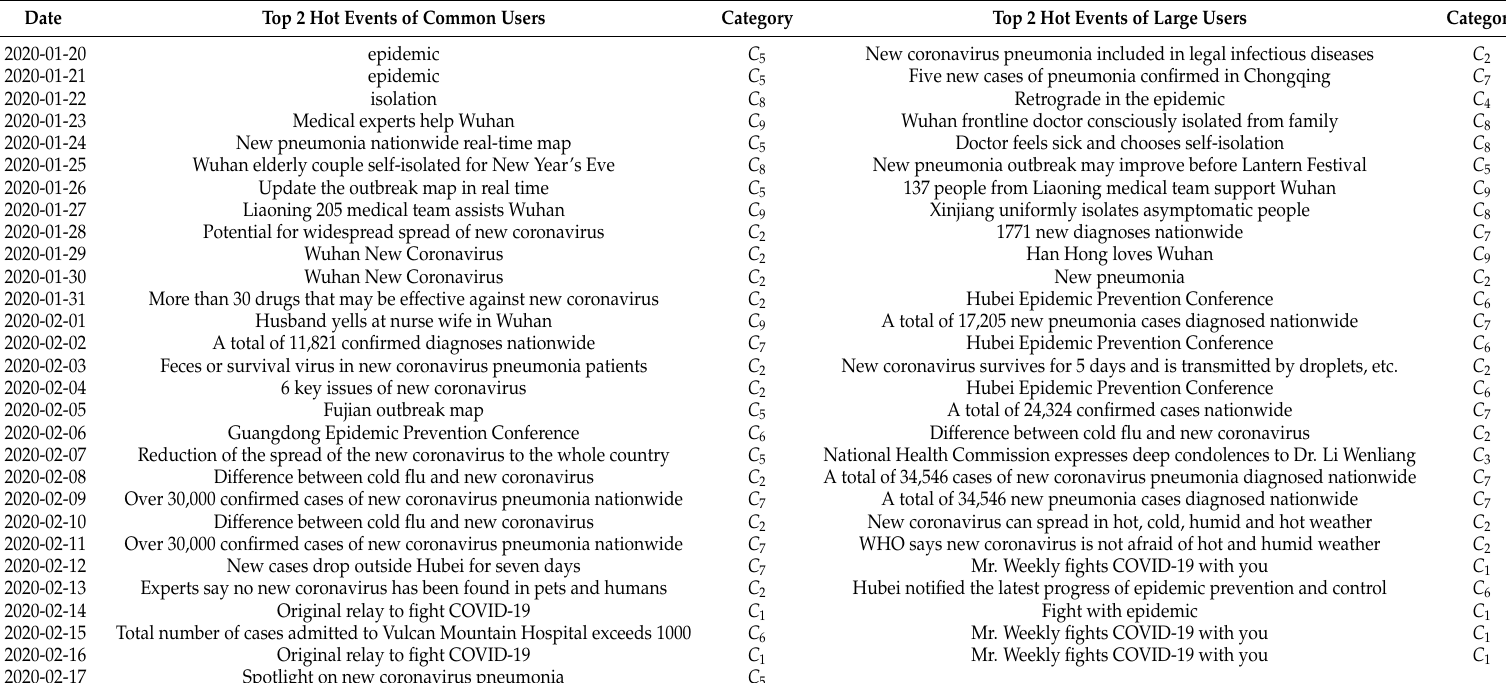
Table A2. Top two hot events among large users and common users on microblog